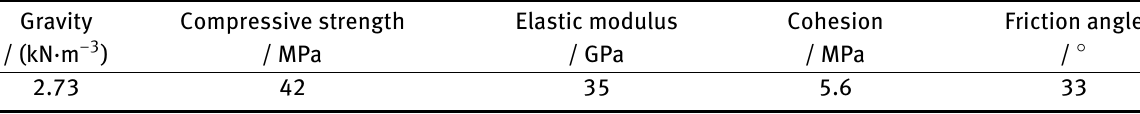
Cohesion Friction angle / MPa / ∘